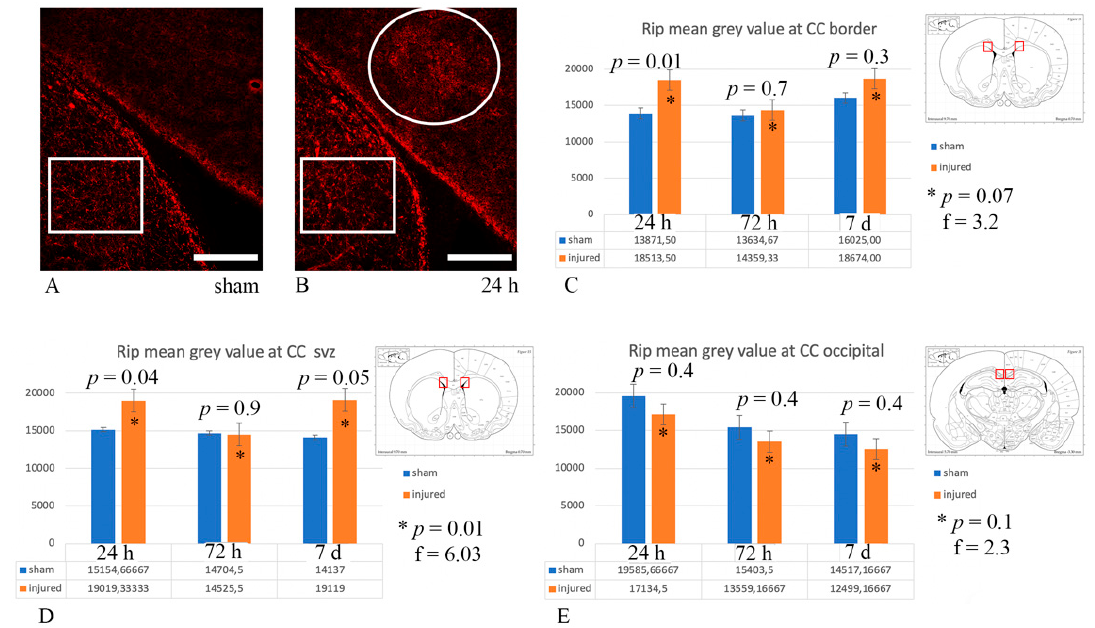
Figure 11. Rip expression analysis. ( A , B ) Examples of Rip expression in the CC “SVZ” in the sham and 24 h injured rat, respectively. The circle highlights an area of Rip expression, which is perceived as brighter, reflecting higher mean grey values (16,000 in ( B )) at the quantitative analysis. Similarly, the rectangles highlight the area of the caudoputamen used as control for mean grey value, which is higher (15,600 and 17,200 in ( A ) and ( B ), respectively) than in the sham CC (13,400 in ( A )). Scale bar = 200 µ m. ( C – E ) The graphs represent quantitative analysis of Rip expression expressed as mean grey values. The ROI for each graph is represented by the red highlighted area in the schematic inserts. ( C ) Statistically significant ( p ≤ 0.05) di ff erence of Rip expression was found between sham and injured animals at 24 h, as well as across injured animals, at the CC border with the caudoputamen. ( D ) Statistically significant ( p ≤ 0.05) di ff erence in Rip expression was also found between sham and injured animals at 24 h and 7 d, as well as across injured animals, at the CC “SVZ”. * p indicates results from one-way ANOVA analysis, while p from Student t